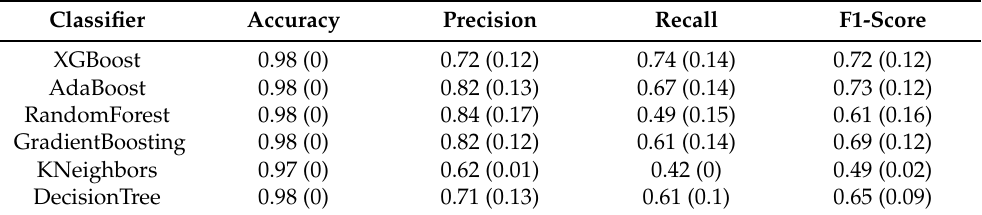
Table 7. Models’ performance for Linear Interpolation after applying class weight (standard deviation in brackets).